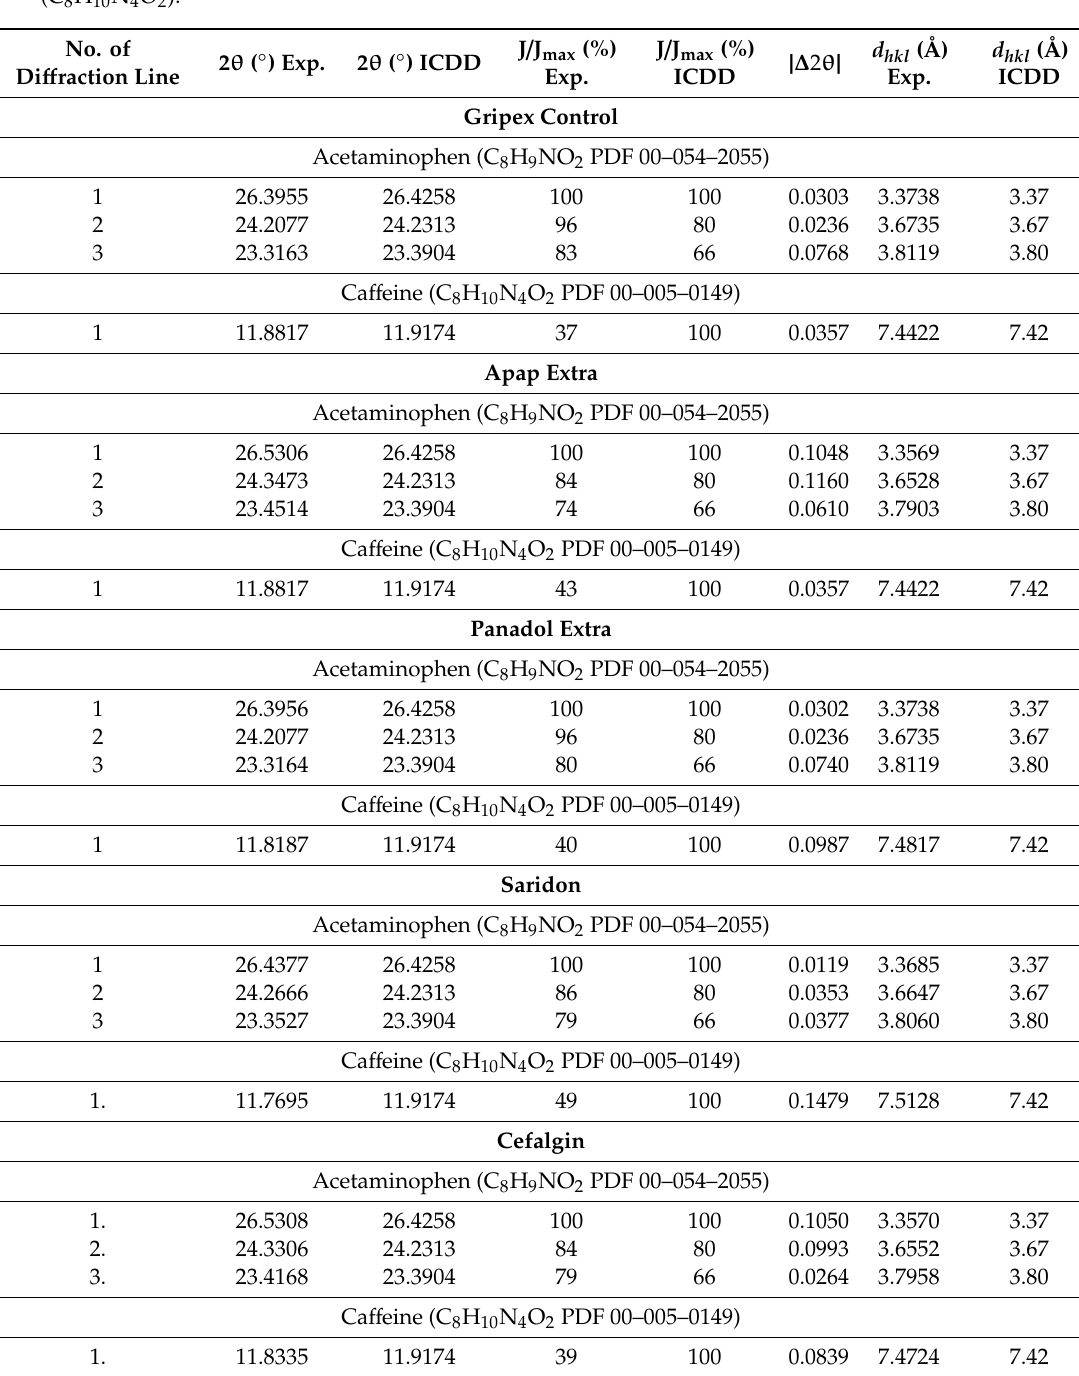
Table 4. Comparison of experimental data with data from the ICDD database for the drugs Gripex Control, Apap Extra, Panadol Extra, Saridon, and Cefalgin containing ACP (C 8 H 9 NO 2 ) and ca ff eine (C 8 H 10 N 4 O 2